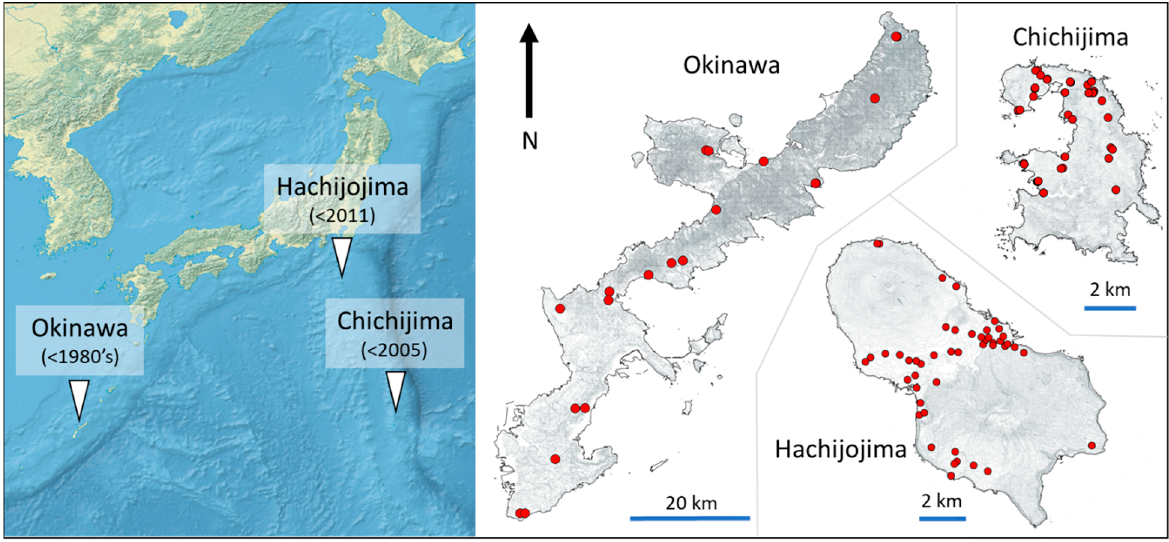
Figure 1. Sample sites of T . brunneus in this study. Earliest reported presence indicated in parentheses. Note different scale bars for each island in the right panel.